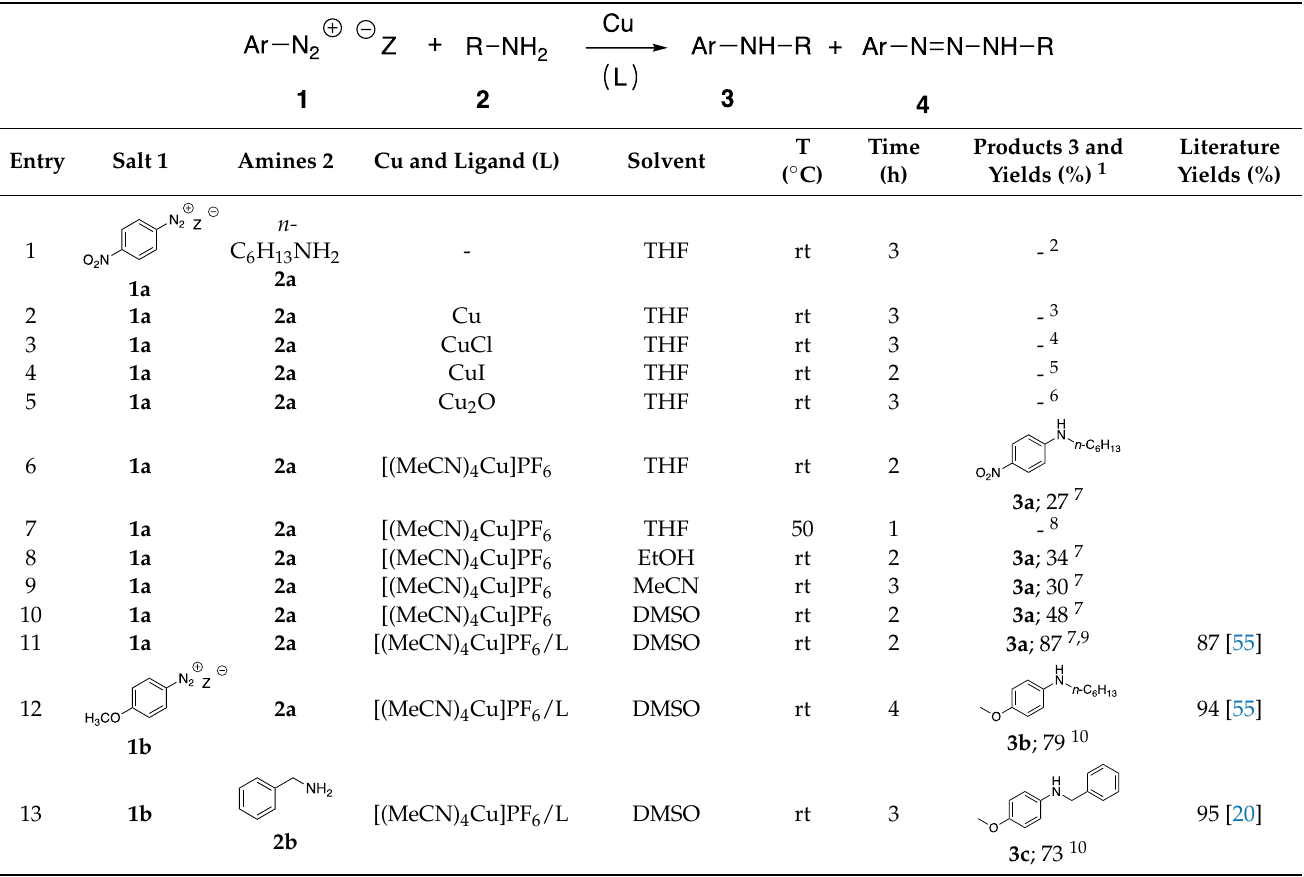
Table 1. Ullmann-type coupling between arenediazonium o -benzenedisulfonimides 1 and amines 2.